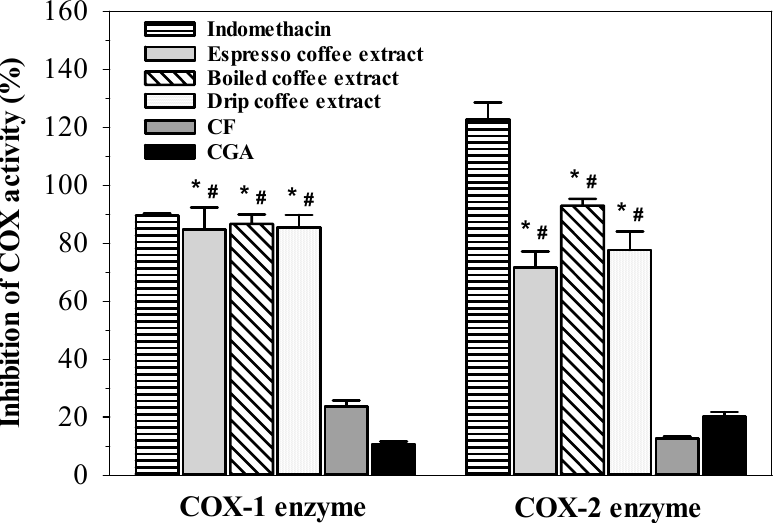
Figure 7. Inhibition of cyclooxygenase 1 (COX-1) and cyclooxygenase 2 (COX-2) activities by in- domethacin (100 mg/mL), caffeine (CF, 100 µ g/mL), chlorogenic acid (CGA, 20 µ g/mL), espresso coffee, boiled coffee, and drip coffee extracts (2 mg/mL each). Data obtained from five separate duplicate measurements are expressed as mean ± SEM values. * p < 0.05 when compared with the CGA; # p < 0.05 when compared to the